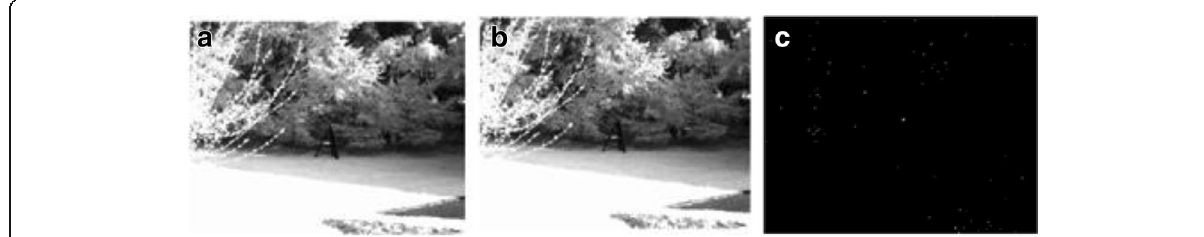
Figure 14 is an example of image difference processing.